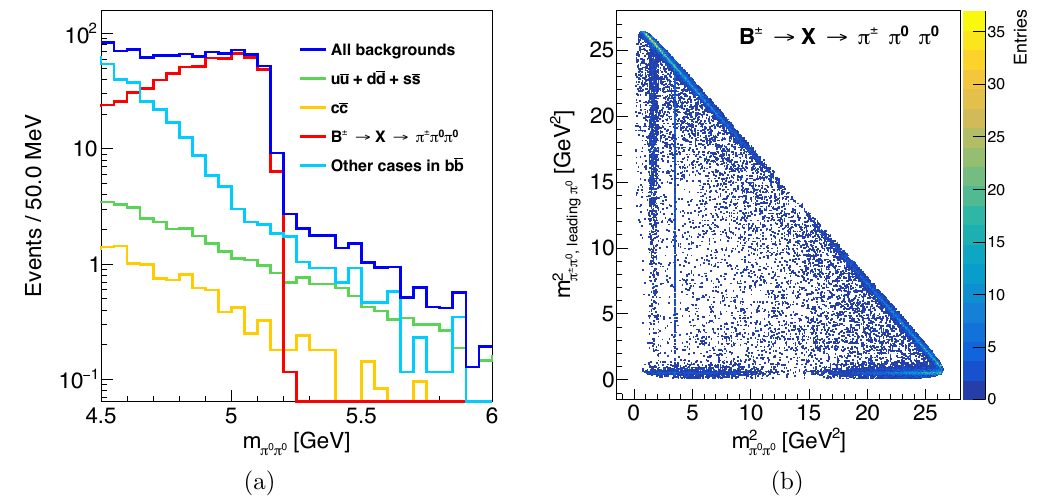
→ π 0 π 0 . (b) Dalitz plot of direct or indirect ( s ) ≈ 1.6 and 3.48 GeV 2 are f 2 (1270) and π 0 π 0